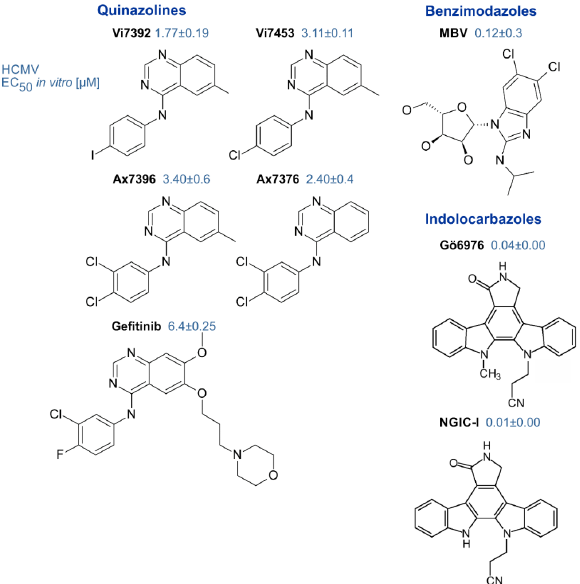
Figure 3. Small molecules derived from different chemical classes possessing strong anti-HCMV e ffi cacy based on their pUL97-inhibitory potential efficacy based on their pUL97-inhibitory potential [44,64,109,123,175,178] . 4. Clinical Investigation of the First Prototype of a Kinase Inhibitor in Antiviral Treatment: Maribavir